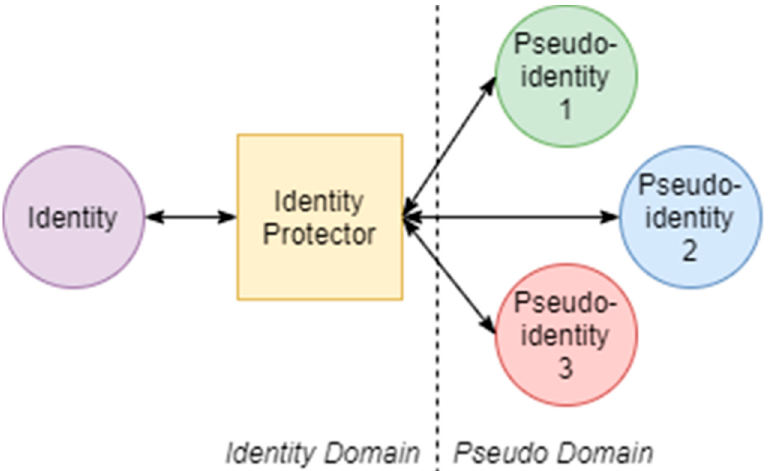
Figure 24. Conceptual overview of Identity Protector separating identity and pseudo domains [66].